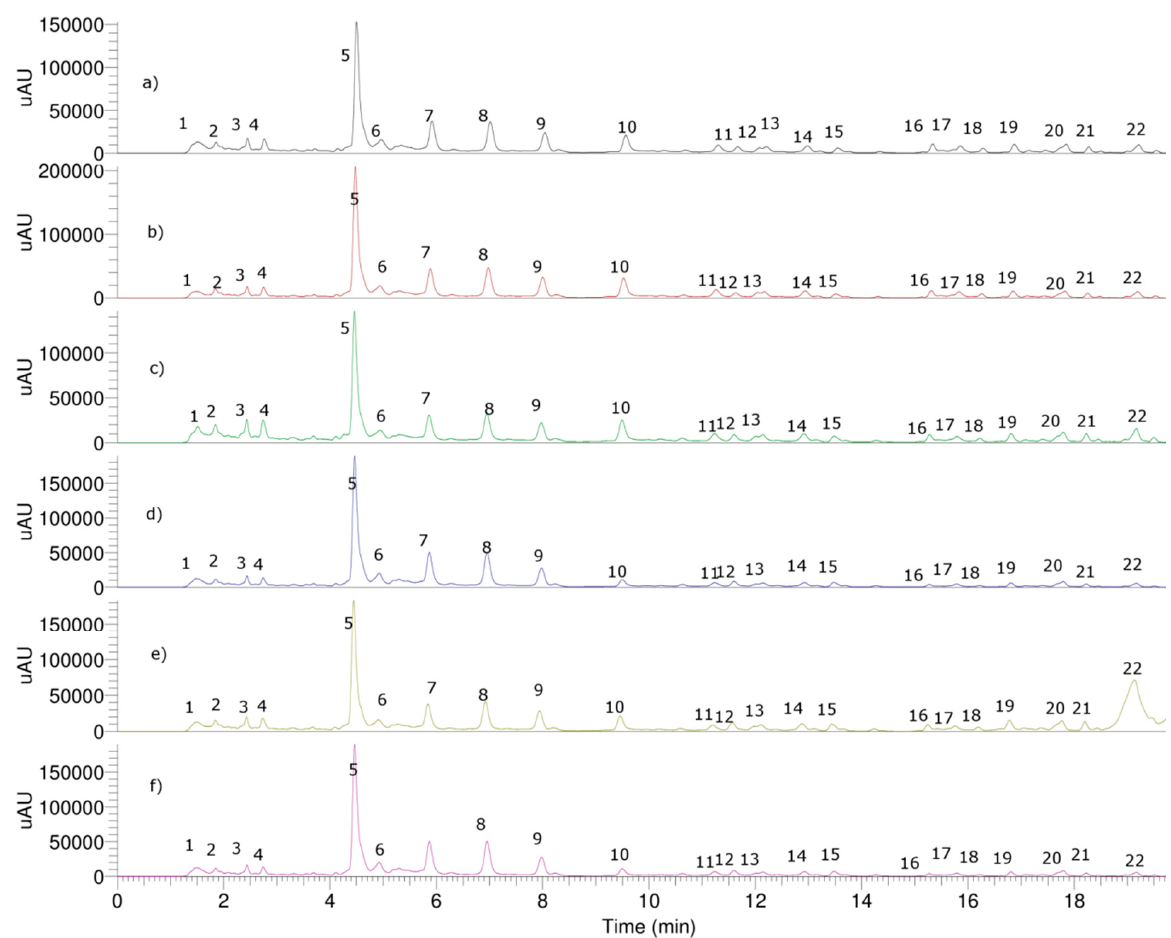
Figure 3. ( a – f ). HPLC-DAD chromatograms at 490 nm of haloarchaea strains: Te Se-85, Te Se-86, ALT-23, TeSe-41, TeSe-51 and TeSe-89.